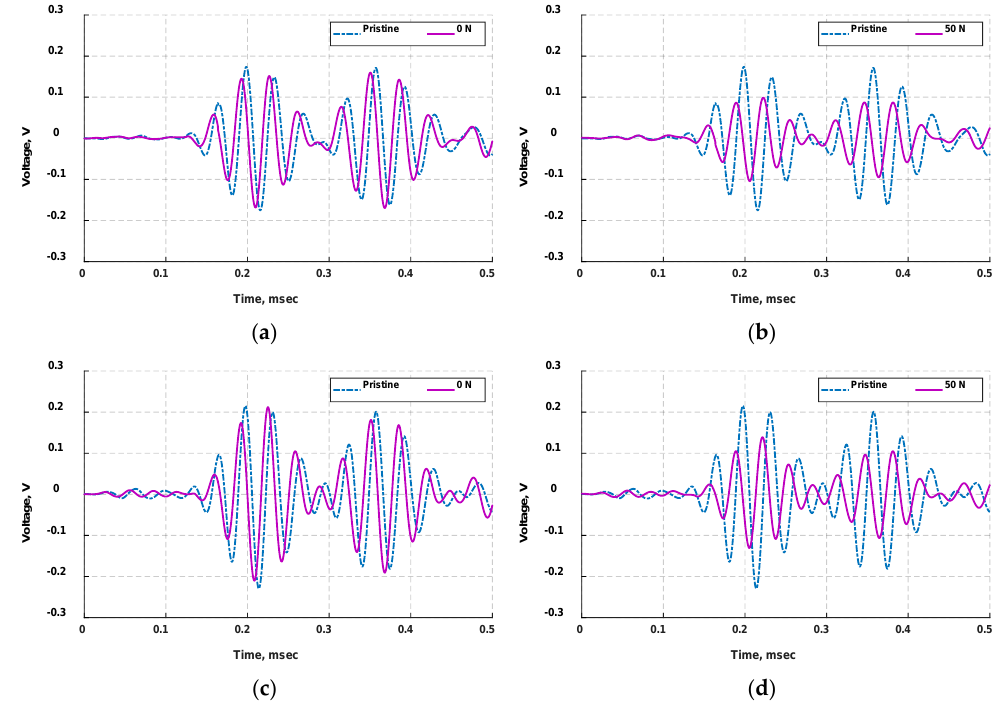
Figure 13. Comparison of voltage signals from laminate specimen at no-preload condition (left column) and 50 N mid-span preload (right column) at 1.3 mm three-point loading cycle: ( a , b ) d15 PZT-2 sensor and ( c , d ) d31 PZT-3 sensor. Scatter